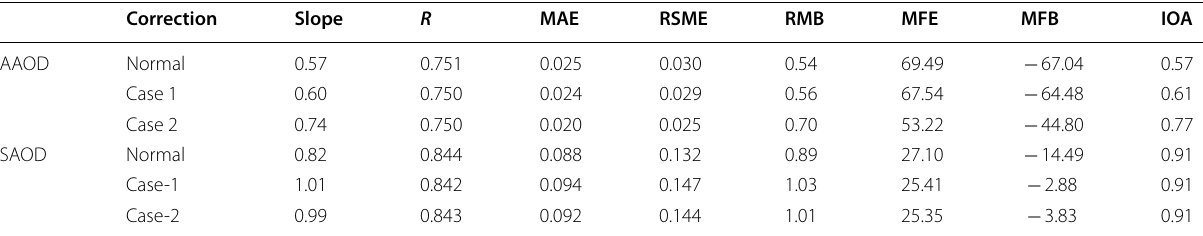
Table 1 Statistical metrics of AAOD and scattering AOD (SAOD) without AOD correction (normal), underestimation of OC AOD (case 1), and identical underestimation of OC and BC AOD (case 2) at the Phimai SKYNET site Correction